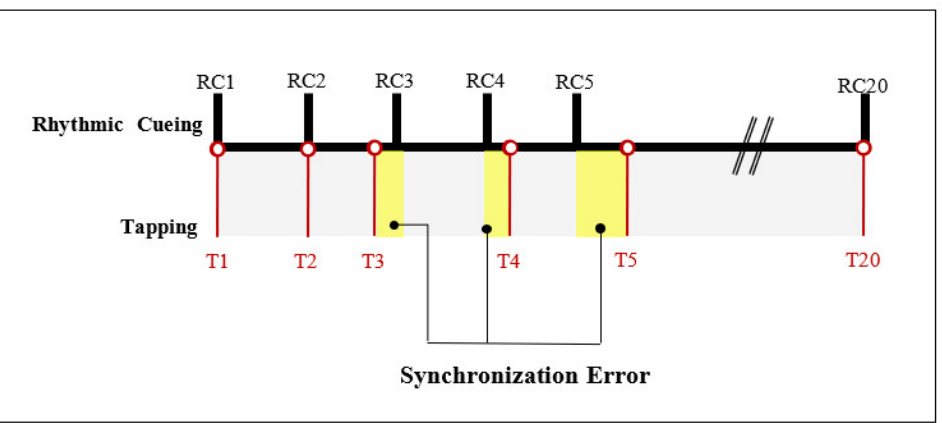
Figure 1. The measurement paradigm of the MIDI drum tapping task. The synchronization error was calculated as the time between rhythmic cueing and drum tapping.